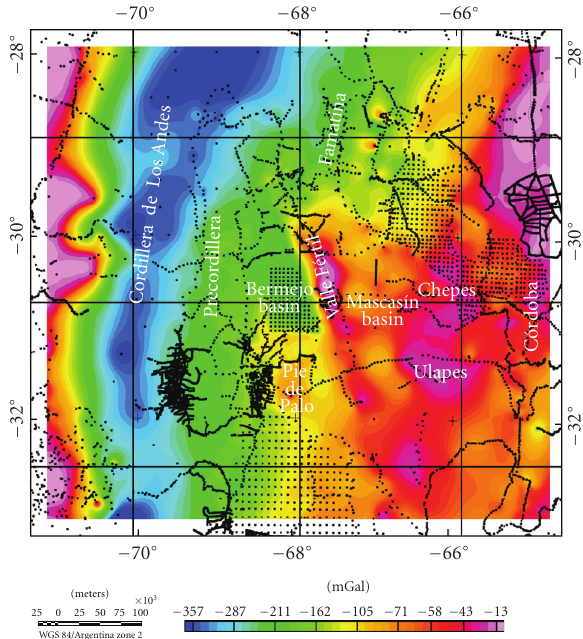
Figure 2: Map of the Bouguer anomaly tied to the IGNS 71 gravity network (data obtained from Instituto Sismologico F. S. Volponi-UNSJ, IFIR-UNR). The gravity stations are indicated as black